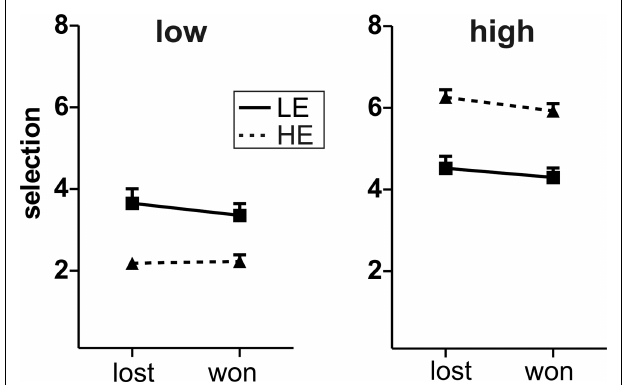
FIGURE 3 | Behavior after lost/won trials. Depicted are the mean selections after lost and won trials, separately for low (left panel) and high (right panel) provocation trials and for the two groups LE (low experimentally induced aggression; solid line) and HE (high experimentally induced aggression; dashed line). Error bars refl ect standard errors.